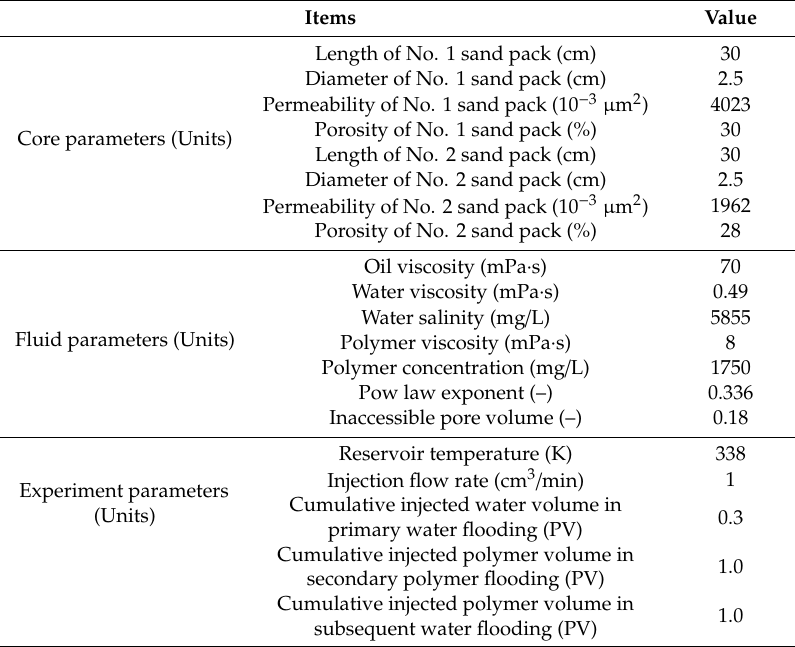
Table 1. Basic parameters of injectivity